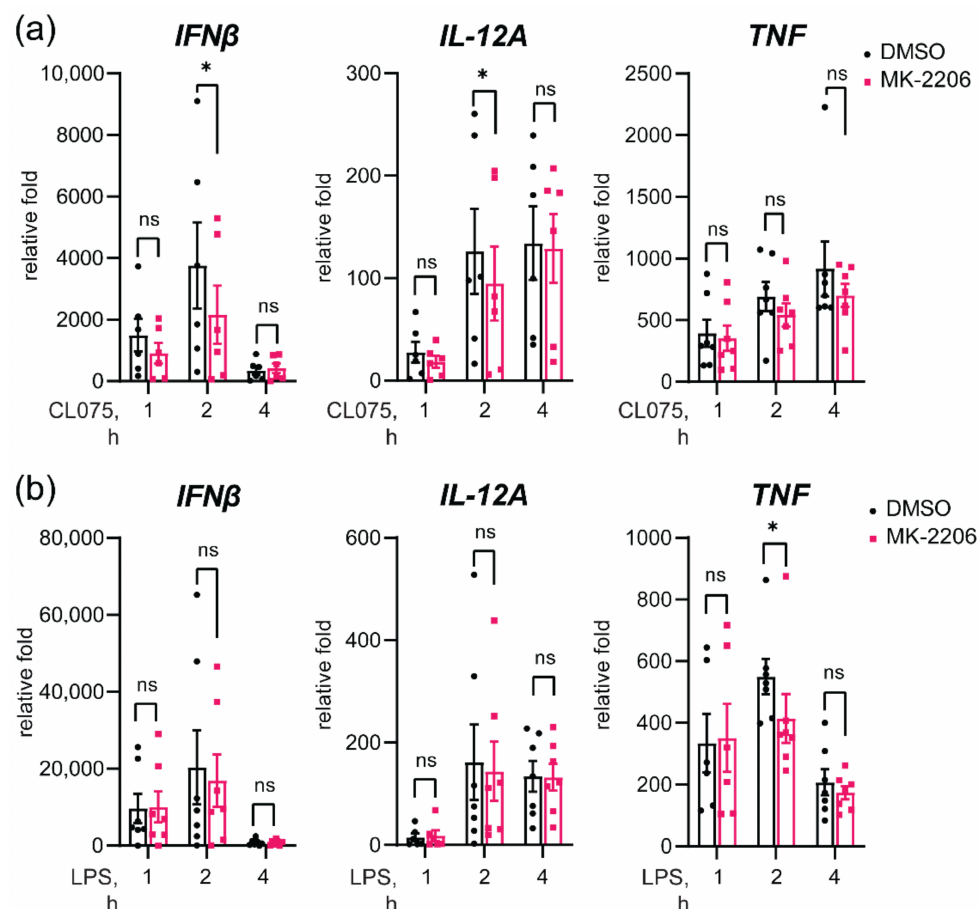
Figure 7. Akt inhibition in MDMs significantly reduces TLR8-mediated expression of IFN β and IL-12A genes, while having no effect on TLR4-mediated cytokine expression. RT-qPCR analysis of cytokine expression after pre-treatment with Akt inhibitor MK-2206 (2 µ M) and stimulation